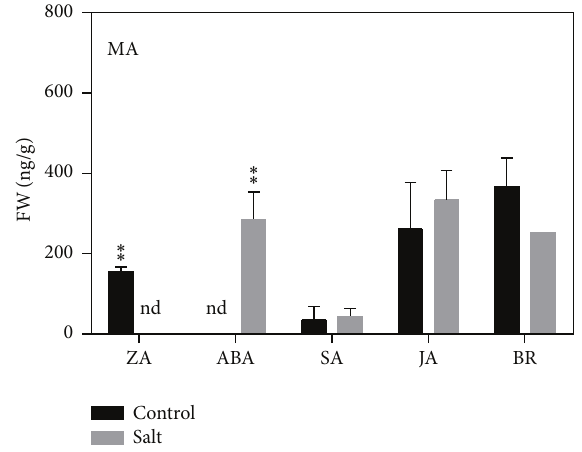
Figure 5: Hormonal levels from normal and salt-stressed A. thaliana rosette leaves samples after extraction using solvent methanol : acetic acid (99: 1, v/v). “FW” represents fresh weight of plant sample. Asterisks indicate significant differences and “nd” refers to not detected ( 𝑛 = 2/3 , 𝑃 < 0.05 , Student’s 𝑡